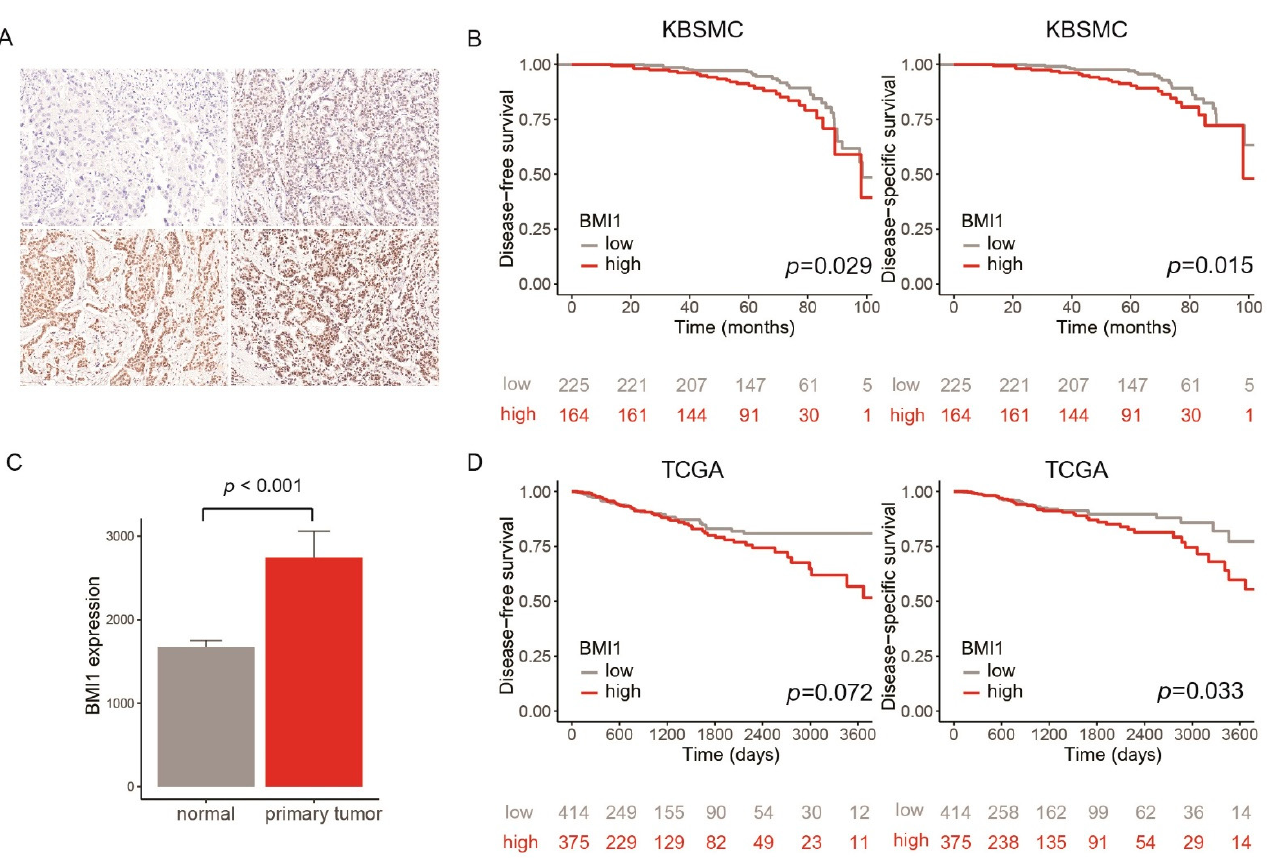
Figure 2. ( A ) The intensity of staining was scored as negative (left top), weak (right top), moderate (left bottom), or strong (right bottom) (original magnification 200 × ). ( B ) Survival analyses of the Kangbuk Samsung Medical Center (KBSMC) cohort: High BMI1 expression was associated with poor disease-free and disease-specific survival ( p = 0.029 and 0.015, respectively). ( C ) Bar plots of The Cancer Genome Atlas (TCGA) cohort data: BMI1 expression was higher in primary tumors ( p < 0.001). ( D ) Survival analyses of the TCGA cohort: high BMI1 expression was associated with worse disease-free and disease-specific survival ( p = 0.072 and 0.033, respectively).